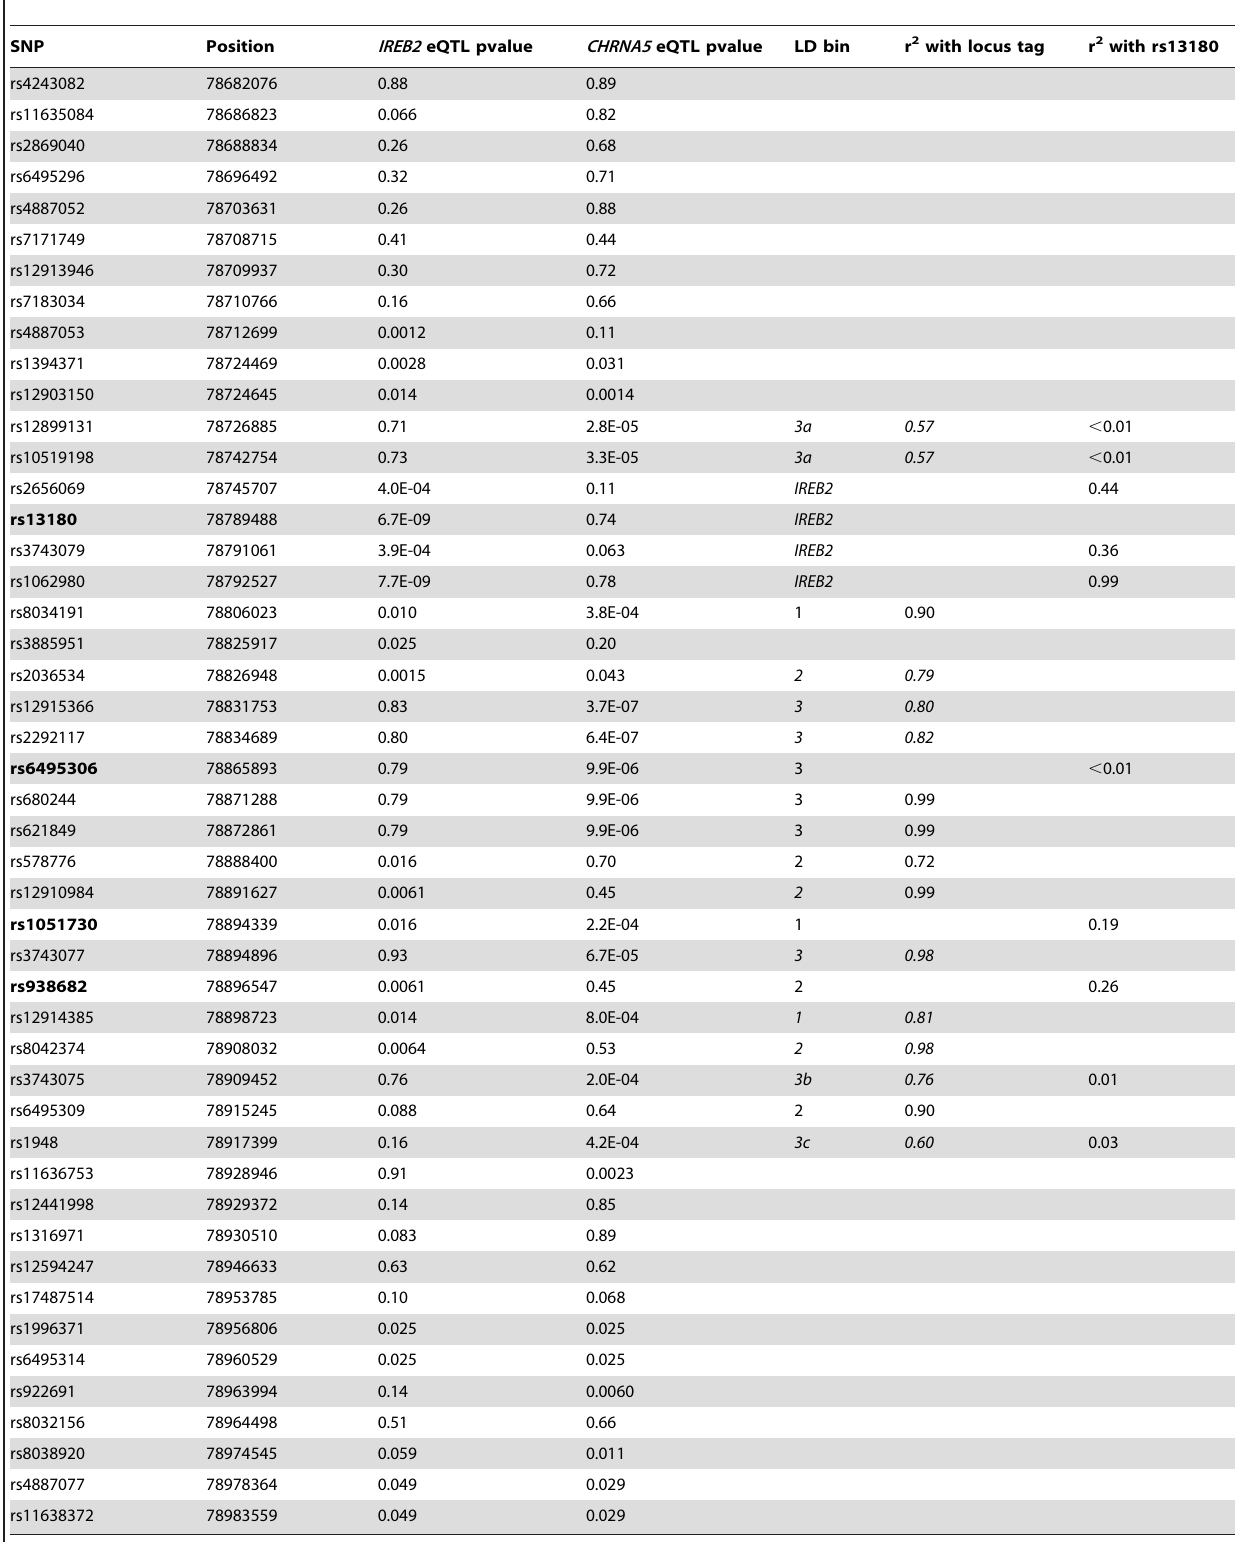
Table 4. Single nucleotide polymorphism (SNP) associations with expression of IREB2 (1555476_at) and CHRNA5 (206533_at) in induced sputum samples from COPD